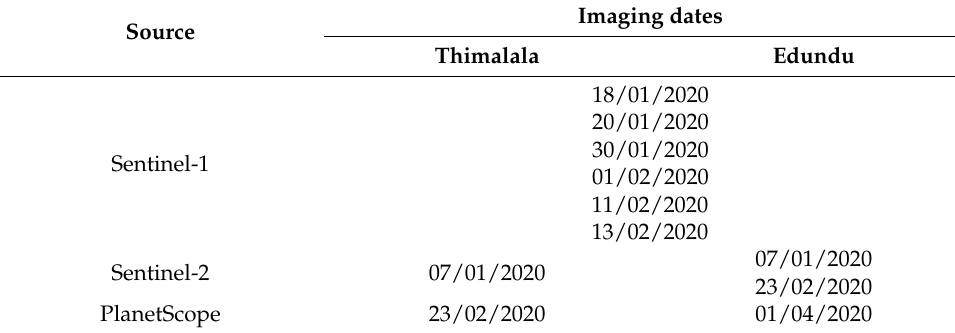
Table 2. List of satellite data used in this study.